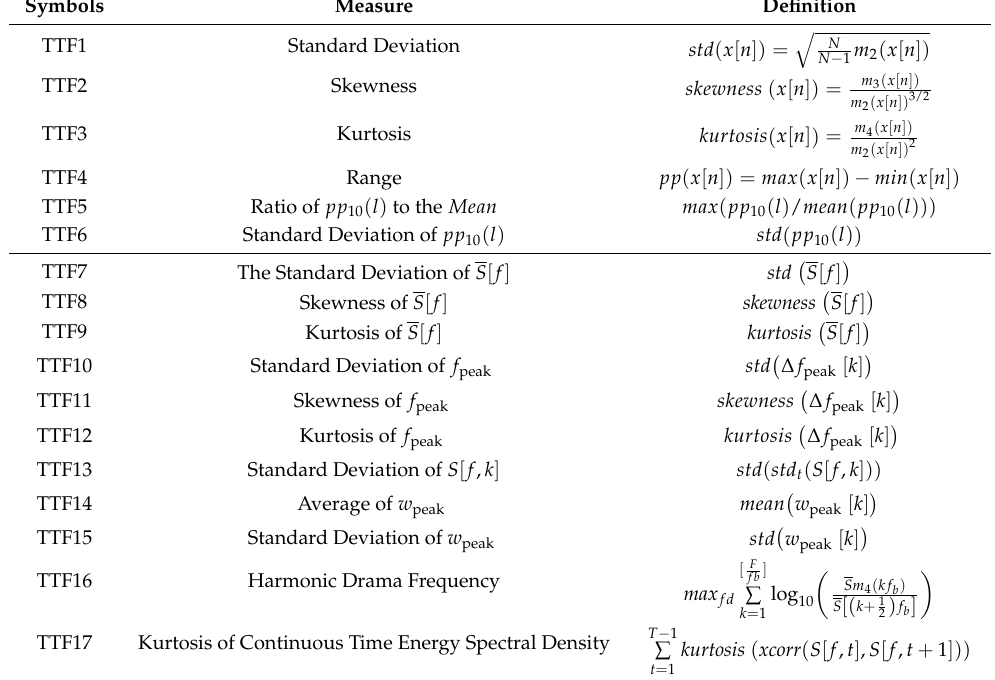
Table 2. The definition of 17 time and time-frequency features.